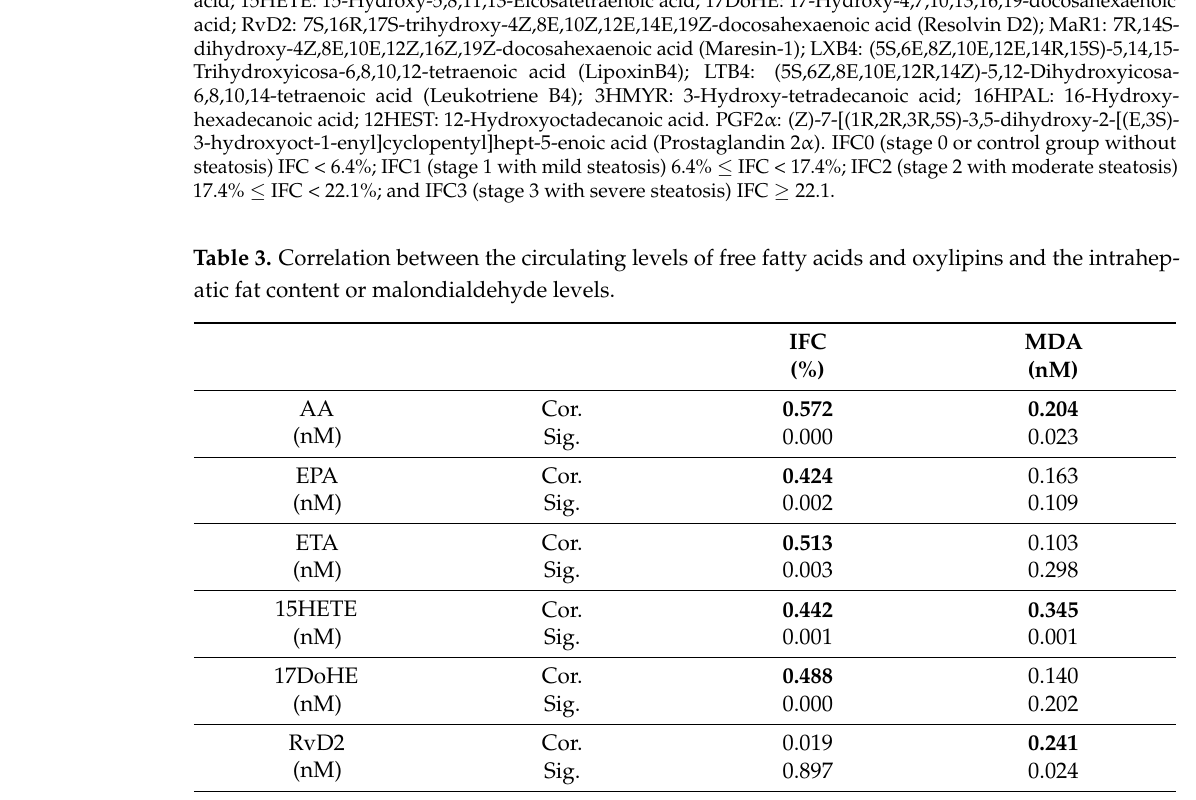
Results represent mean ± SEM. Statistical analysis: One-way ANOVA for normally distributed data. When a significant effect of the ANOVA was found, a Bonferroni test was performed to identify differences be- tween groups. Different letters (a, b) indicate significant differences between groups ( p < 0.05). AA: 5,8,11,14- Eicosatetraenoic acid (Arachidonic acid); EPA: 5,8,11,14,17-eicosapentenoic acid; ETA: 8,11,14,17-eicosatetraenoic